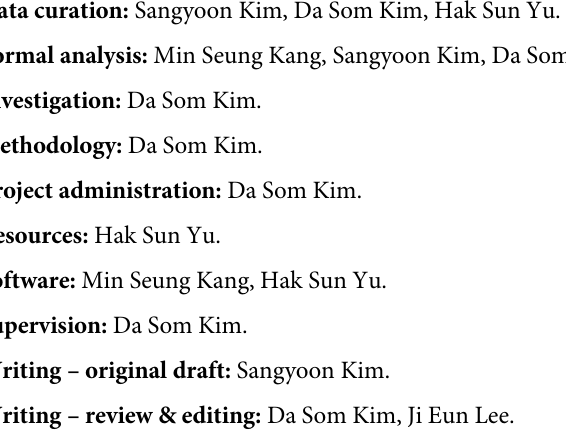
S1 Table. Dataset yielded from the experiment. The dataset is the result from alamarBlue ™ assay, ATP measurement by CellTiter-Glo 1 Luminescent Cell Viability Assay, and membrane permeability measurement by the SYTOX Green assay, which were conducted in this